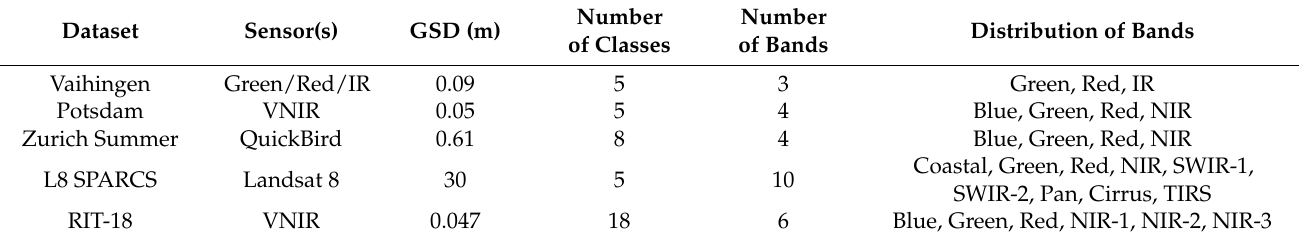
Table 1. Summary of five commonly used multispectral